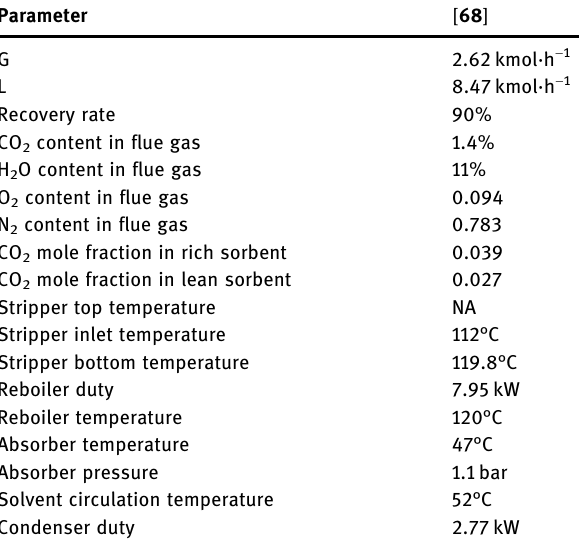
Table A2: Operating condition for conducting exergy and energy analysis